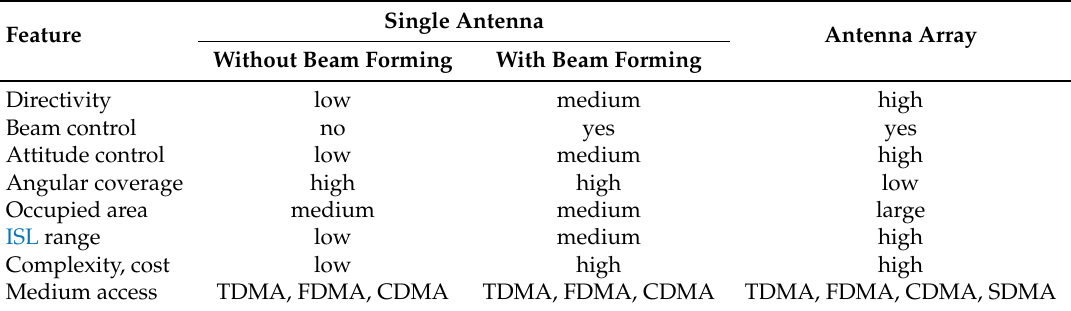
Table 7. Comparison of antenna concepts for ISL